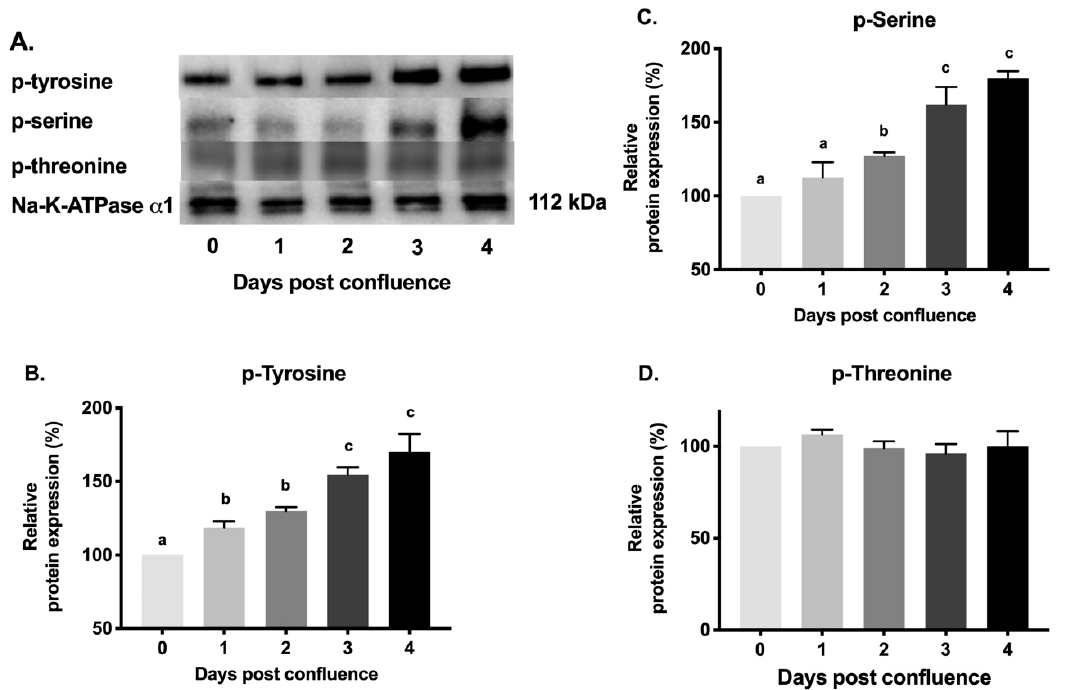
Figure 8. Western blot analysis of phosphorylation levels of Na-K-ATPase α 1 in plasma membrane during di ff erent days post confluence. ( A ). Representative blot of p-tyrosine, p-serine, p-threonine and Na-K-ATPase α 1 after immunoprecipitation with Na-K-ATPase α 1 antibody. Densitometric quantitation of Western blots. ( B ). p-tyrosine. ( C ). p-Serine. ( D ). p-Threonine. Values are relative to 0-day and normalized to Na-K-ATPase α 1. Values are represented as mean ± SEM, n = 3. Values not sharing common superscripted letters are significantly di ff erent at p < 0.05.